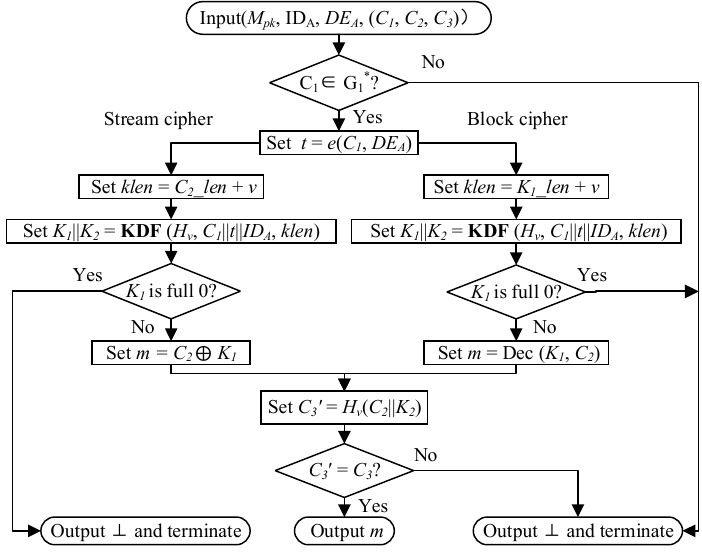
Figure 3. Decryption algorithm flow.